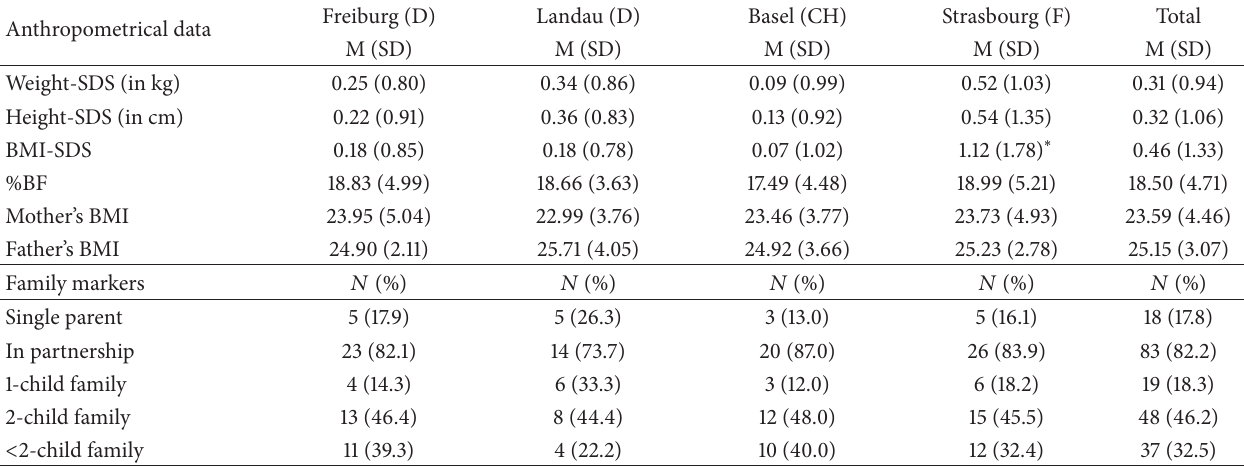
Table 3: Distribution of the anthropometrical data and family markers in the sample differentiated by cities. Anthropometrical